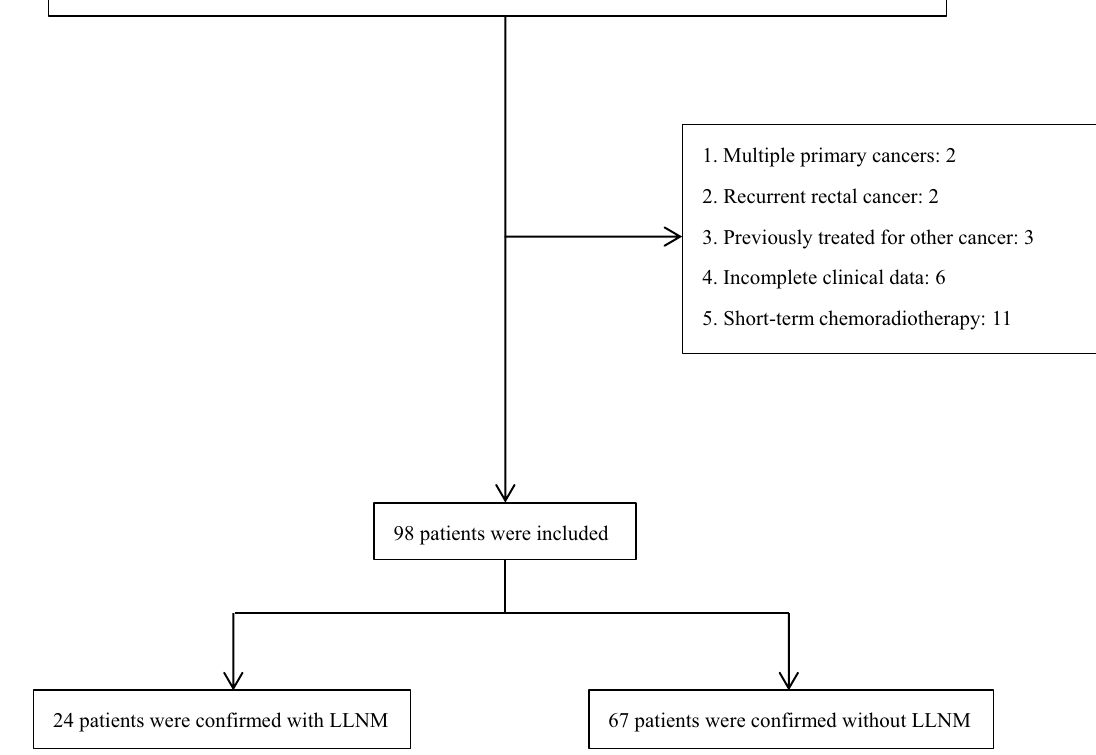
Fig. 3 Flow chart of the study population. LLNM: lateral lymph node metastasis; TME total mesenteric resection; LLND lateral lymph node dissection; nCRT neoadjuvant chemoradiotherapy